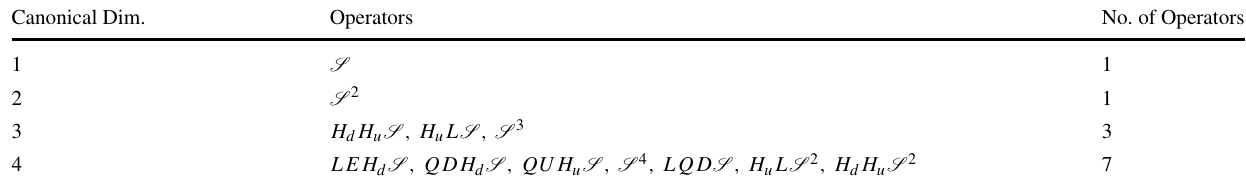
Table 52 Next to minimal supersymmetric standard model: operators constituted only of chiral superfields Canonical